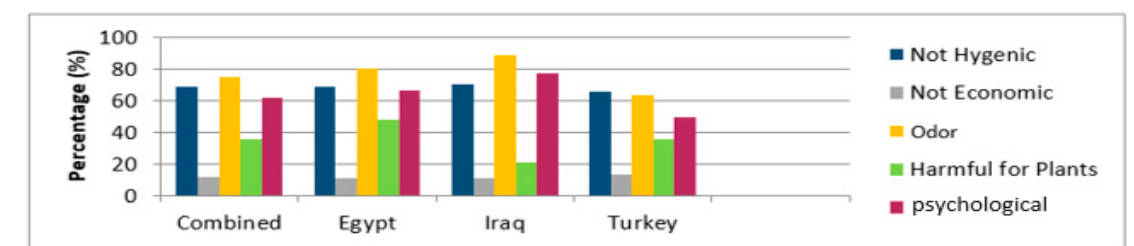
Figure 6. Motivations of the participants.